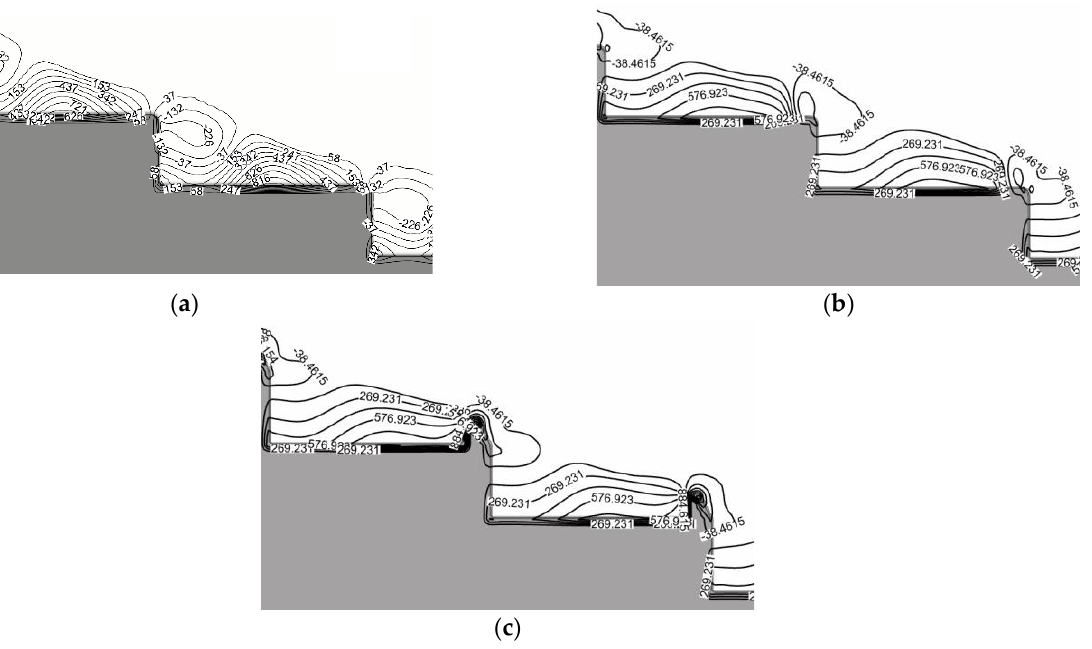
Figure 9. Pressure distribution on the horizontal and vertical surfaces of the step: ( a ) horizontal surface pressure distribution graph; ( b ) vertical surface pressure distribution diagram.